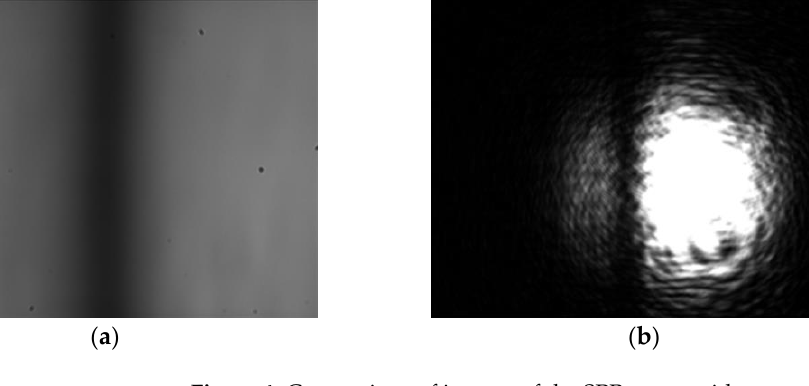
Figure 4. Comparison of images of the SPR curve with a monochrome camera: ( a ) for an AO filter with the central wavelength λ ≈ 633 nm; ( b ) for a helium-neon laser, λ = 632.8 nm. The images are the angular distribution of the reflected radiation from the base of the prism; ( c ) SPR observation design (top view); the dashed line is the image plane.